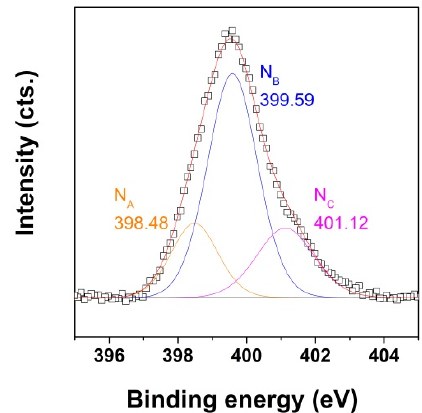
Figure 8. XPS N1s spectra for EDA-functionalized GO aerogels obtained aerogel obtained at 140 °C from a 2 mg · mL − 1 dispersion of GO where C/O = 1.85 and GO/EDA = 1:2.5. Table 1. N configuration (XPS quantification) of N-doped graphene aerogels as a function of synthesis conditions (temperature, GO/EDA, and GO concentration). (type N % calculated from total N content) .